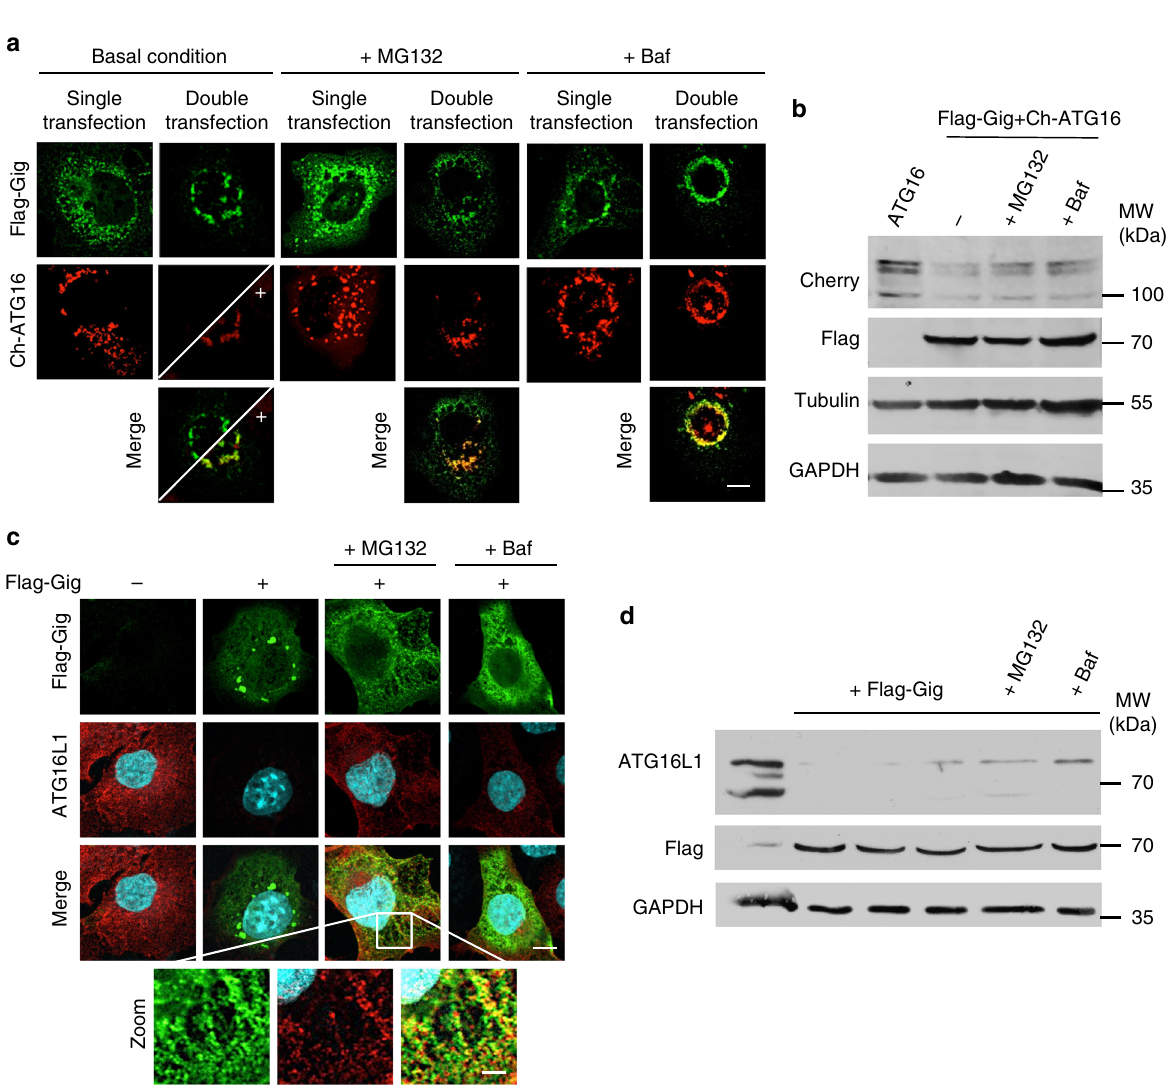
Fig. 2 Gigaxonin induces the degradation of ATG16L1, through the proteasome and the lysosomal pathways. a Immuno fl uorescence of COS-7 cells transfected with Flag-Gigaxonin and Cherry-ATG16L1 alone (single transfection) or together (double transfection), in basal condition, or treated with MG132 or Ba fi lomycin A1 (Baf). Gigaxonin-dependent degradation of ATG16L1 is rescued upon both treatments. b Immunoblotting of cell extracts prepared as in a to show the proteasome and autophagy-dependent degradation of ATG16L1 by Gigaxonin. Immuno fl uorescence ( c ) and immunoblotting ( d ) showed that endogenous ATG16L1 protein is greatly diminished in Gigaxonin transfected cells, and partially restored under MG132 or Ba fi lomycin A1 treatment. Scale bar: 10 µ m and 50 µ m for zoom